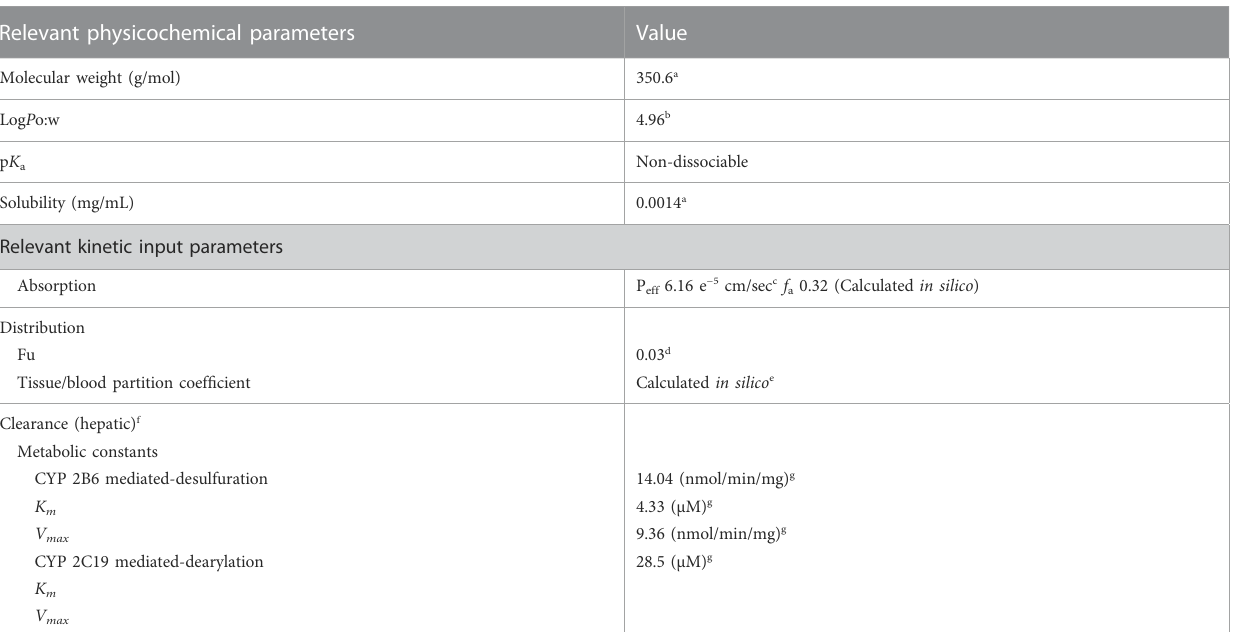
TABLE 1 Summary of physicochemical and physiological input parameters for CPF-PBK